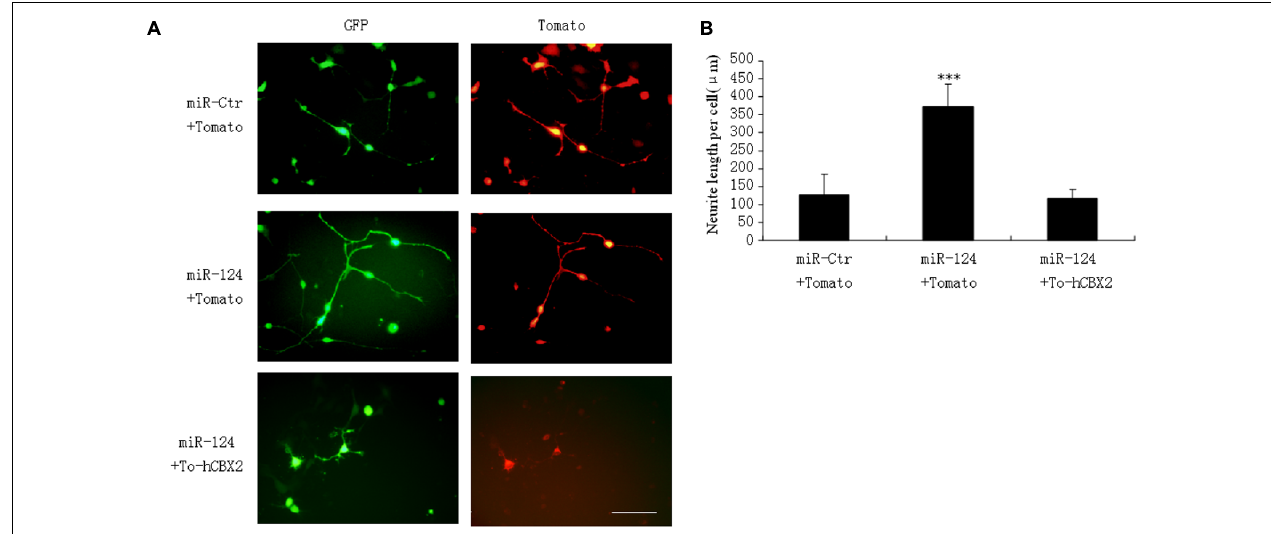
FIGURE 4 | CBX2 over-expression inhibits the neurite stimulating effect of miR-124. (A) The morphology of M17 cells transfected with the indicated vectors was monitored by Td-tomato fluorescence. (B) Quantification of the neurite length of the indicated groups is shown. Scale bar: 100 µ m. The data are presented as mean ± SD, n = 30 cells, ∗∗∗ P <